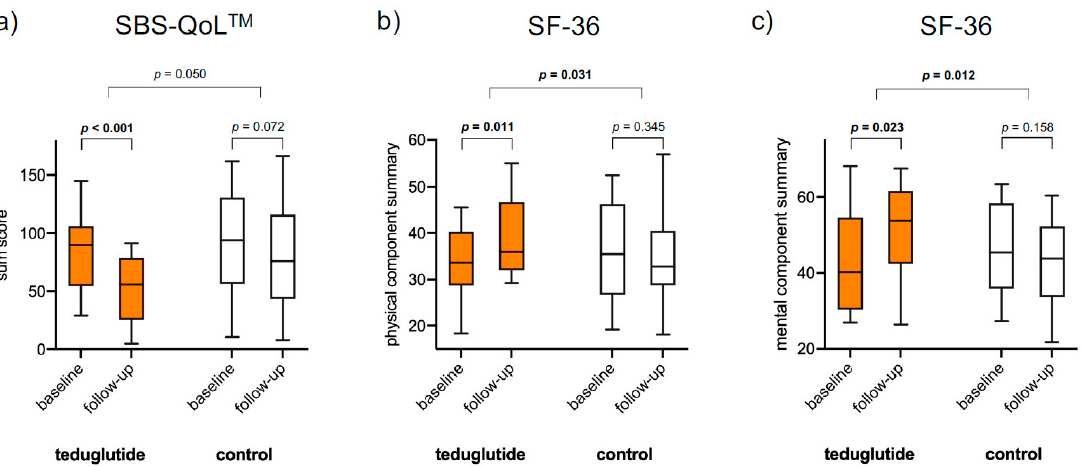
Figure 2. QoL changes over time and between groups. SF-36: positive changes representing QoL improvement; SBS-QoL TM : negative changes representing QoL improvement. Presented are means. QoL change over time in teduglutide-treated vs. non-treated patients (between- group comparison) showed statistical signi fi cance in both SF-36 summary scales ( p = 0.031 and p = 0.012, Table